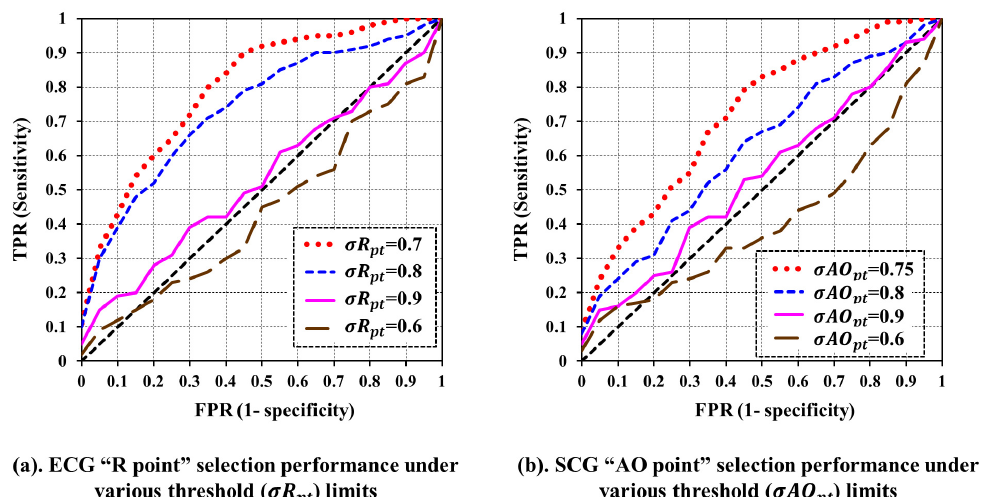
Figure 6. Evaluation of delineation of ECG feature point R and SCG feature point AO